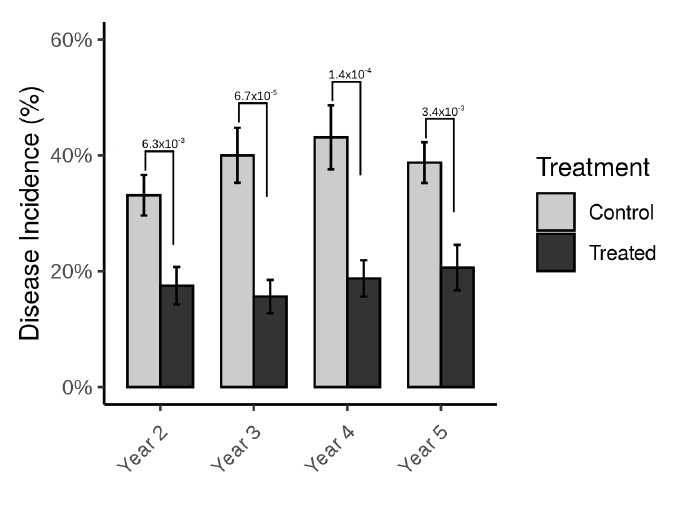
Figure 5. Disease incidence as expressed by the number of cordons showing wood necrotic symptoms in treated and untreated blocks for four consecutive years. Poisson regression followed by a post-hoc Dunnett test was used to determine statistical di ff erence between treated and untreated vines, and p values are presented above the bars. N = 150 vines.